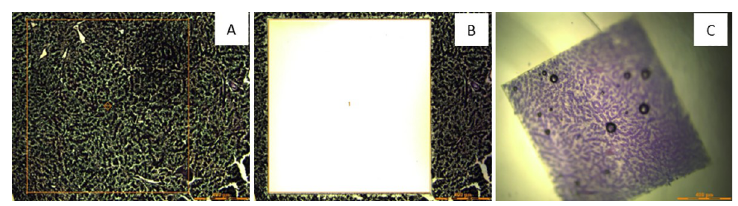
Fig 1. Laser capture microdissection of a smallmouth liver section. (A) Liver section prior to microdissection. (B) Liver section after microdissection. (C) Liver section floating in buffer in the cap of a microcentrifuge tub prior to nucleic acid